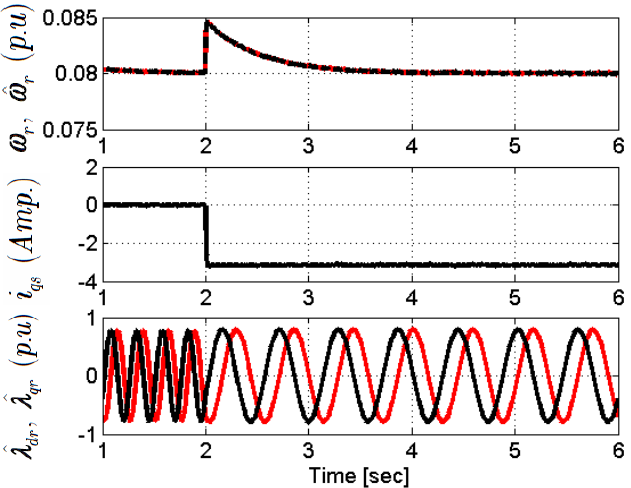
Figure 13. Simulation tests at a speed reference of 0.08 p.u (12.56 rad/s) with rated T L change of − 7 N.m at t = 2 s.